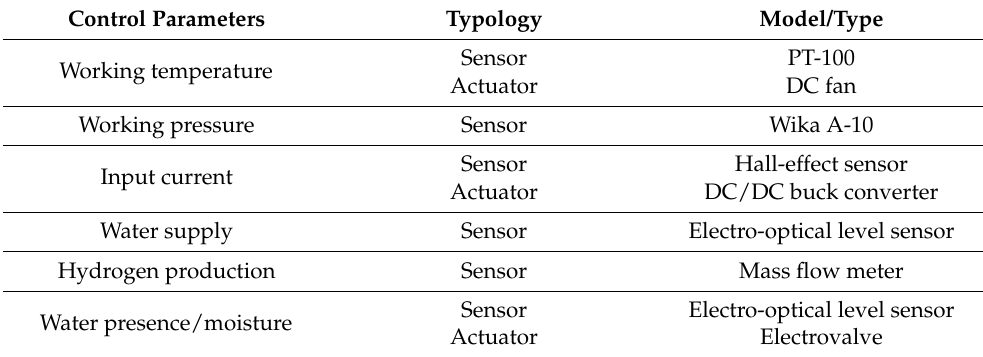
Table 1. Control parameters, sensors, and actuators.